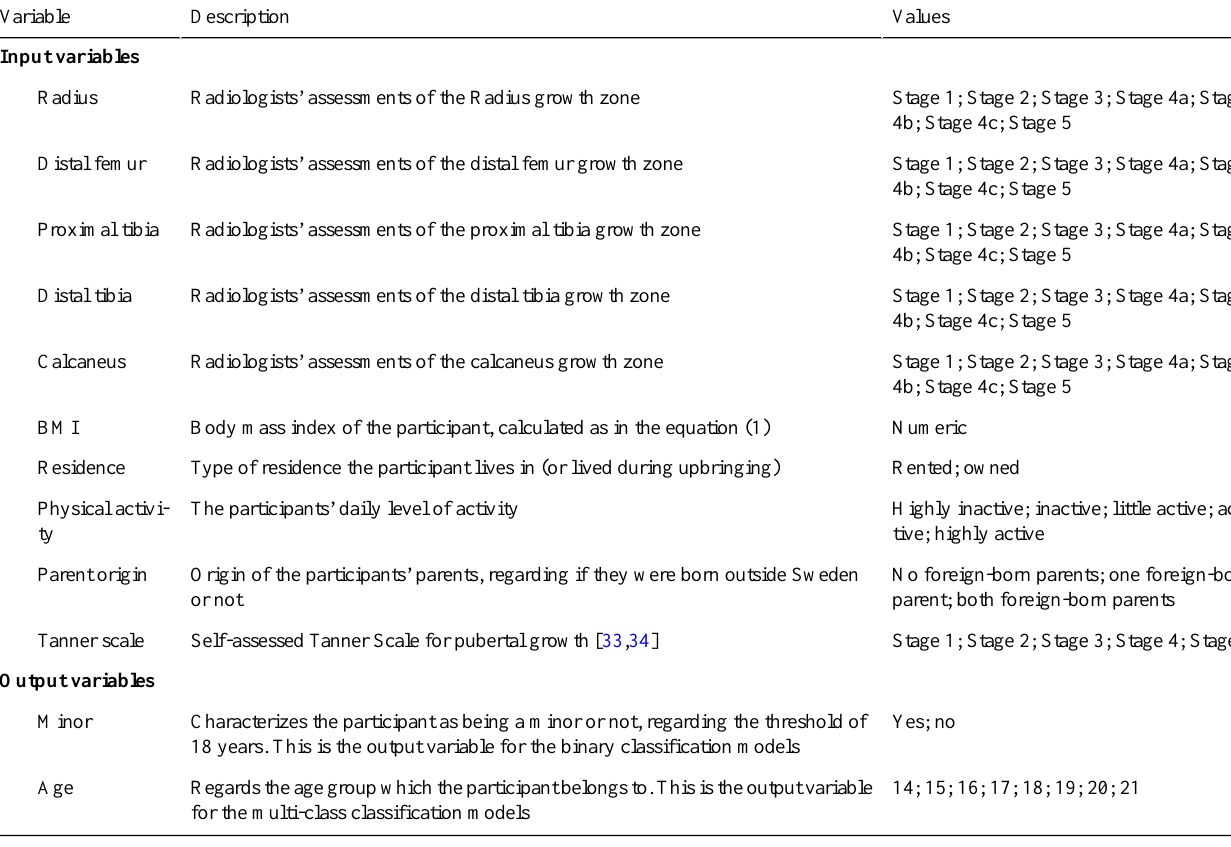
Table 2. Summary of the input and output variables considered in the model